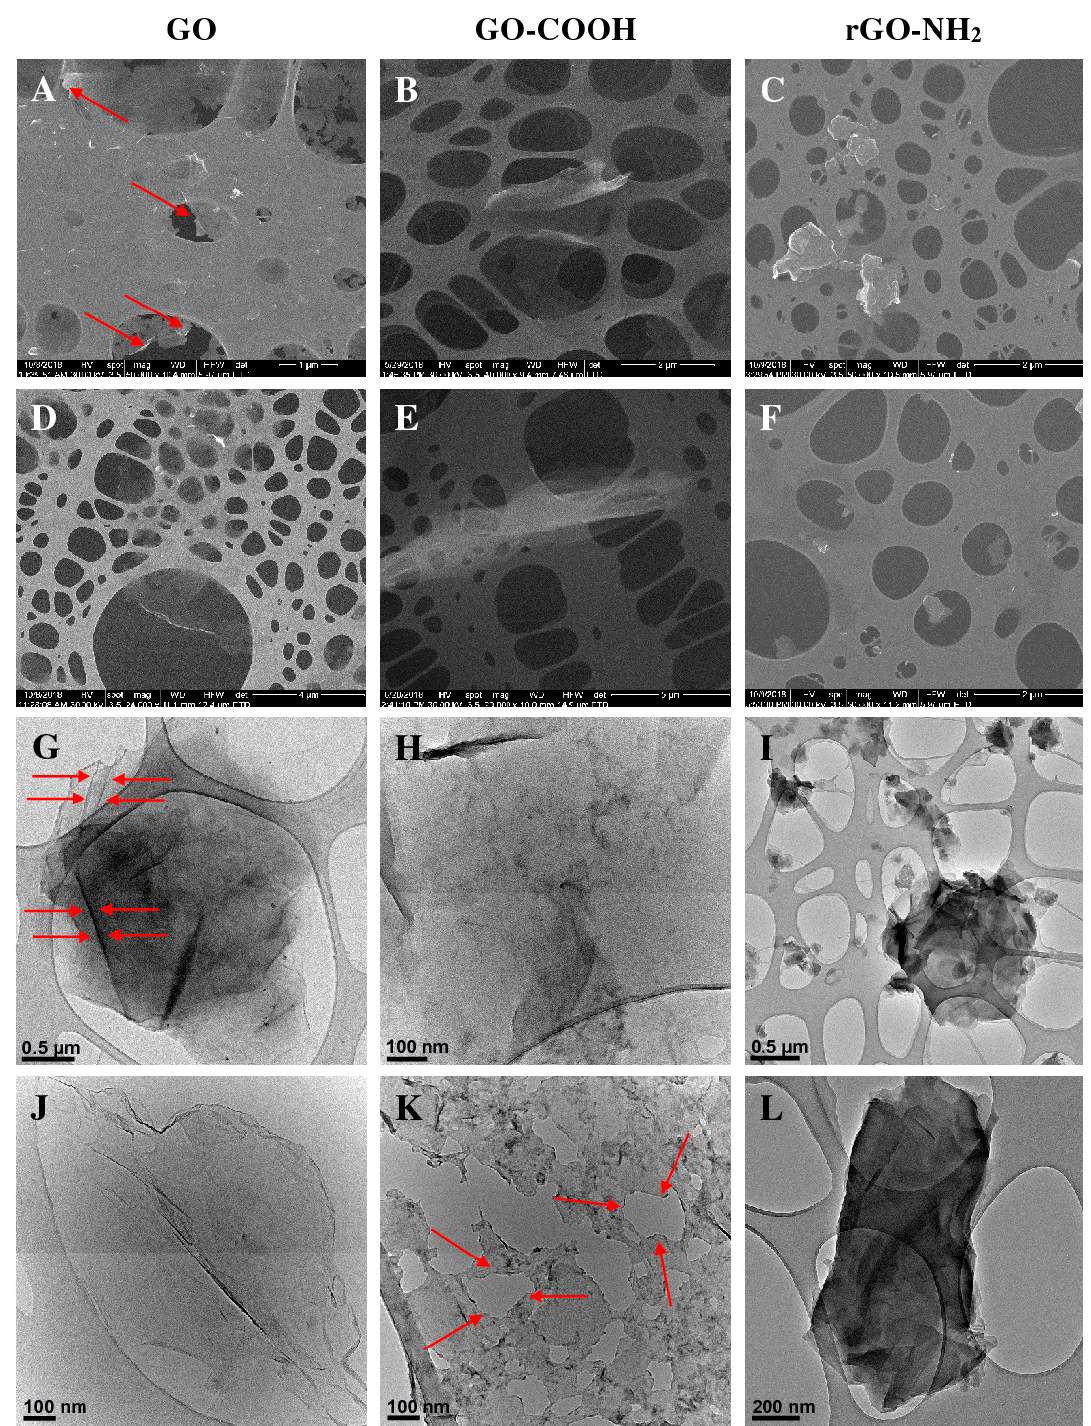
Figure 4. The impact of ultrasound treatment duration on GO, GO-COOH and rGO-PEG-NH 2 as seen through scanning electron microscopy (SEM) ( A – F ) and TEM ( G – L ) images. Morpho-structural alterations induced by 1 h sonication are depicted in panel ( A ) (red arrows: incipient edge peeling) and ( G ) (red arrows: structural folding wrinkled surface) for GO, ( B , H ) for GO-COOH, ( C , I ) for rGO-PEG-NH 2, whereas panels ( D , J ) correspond to GO, ( E , K ) (red arrows: layer cleavage) to GO-COOH, ( F , L ) to rGO-PEG-NH 2 after 2 h sonication.